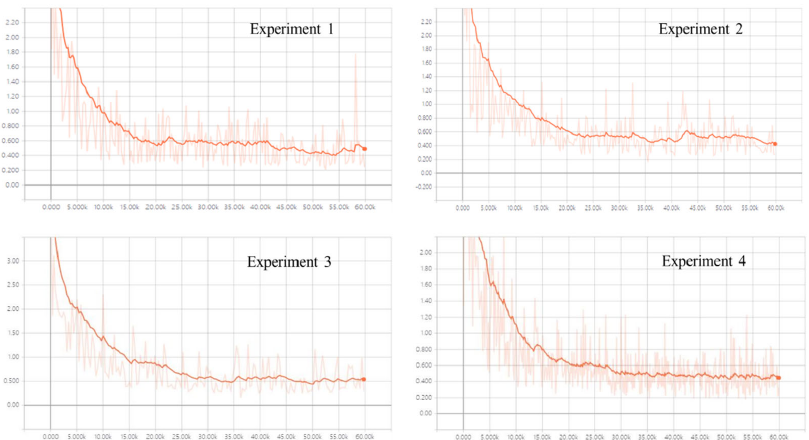
Figure 8. Training loss of each experiment.